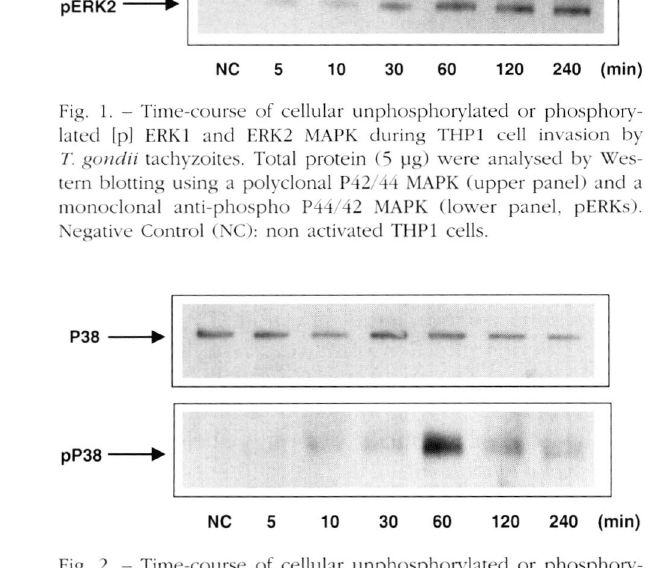
Fig. 2. - Time-course of cellular unphosphorylated or phosphory- lated [p] P38 MAPK during THP1 cell invasion by T. gondii tachy­ zoites. Total protein (10 µg) were analysed by Western blotting using a polyclonal P38 MAPK (upper panel) and a polyclonal anti-phospho P38 MAPK (lower panel, pP38). Negative Control (NO: non activa­ ted THP1 cells.